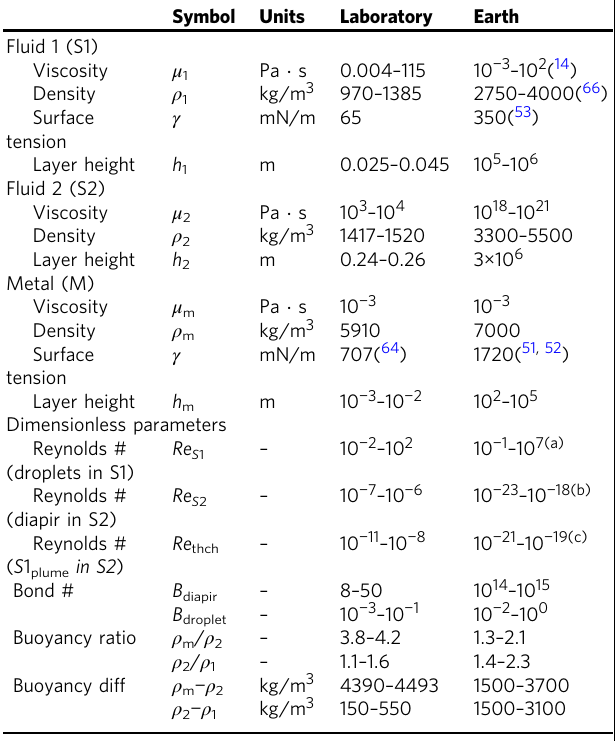
Table 2 Fluid properties and non-dimensional parameters Symbol